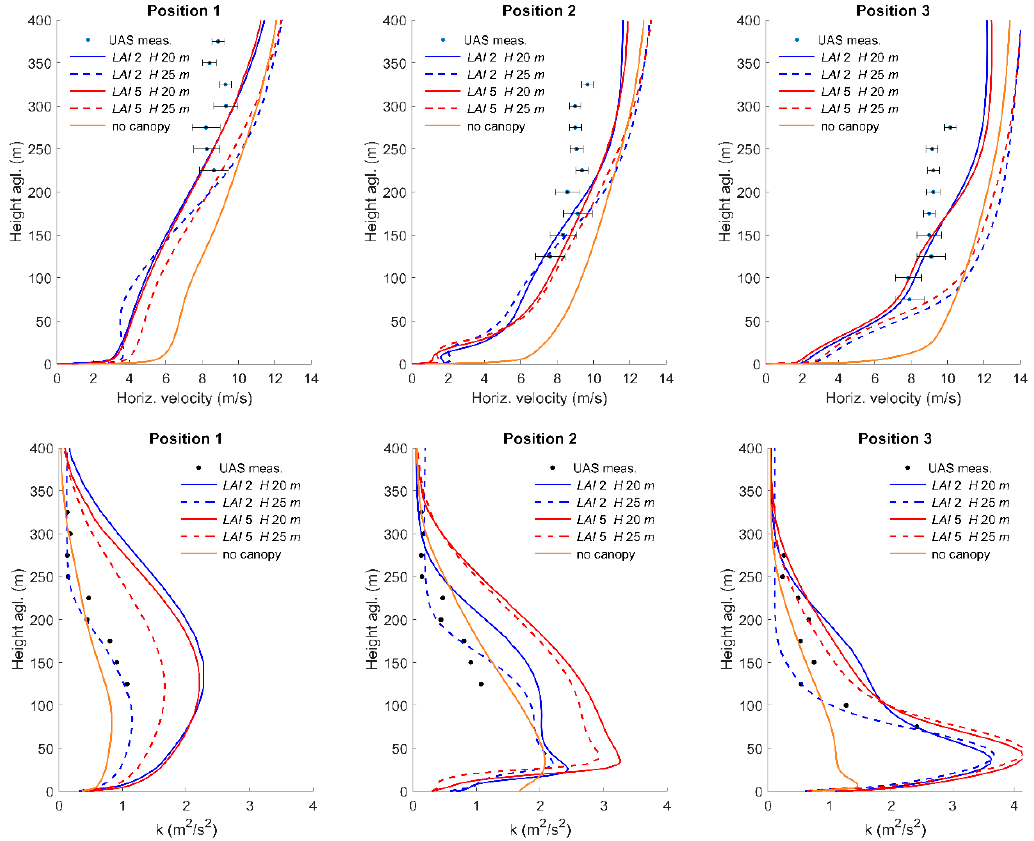
Figure 15. Vertical profiles of the horizontal velocity and the turbulent kinetic energy at three positions on the 27 March 2015. The dots are the UAS measurements and lines of the simulation results. The colors represent the different values of 𝐿𝐴𝐼 and height for the forest.